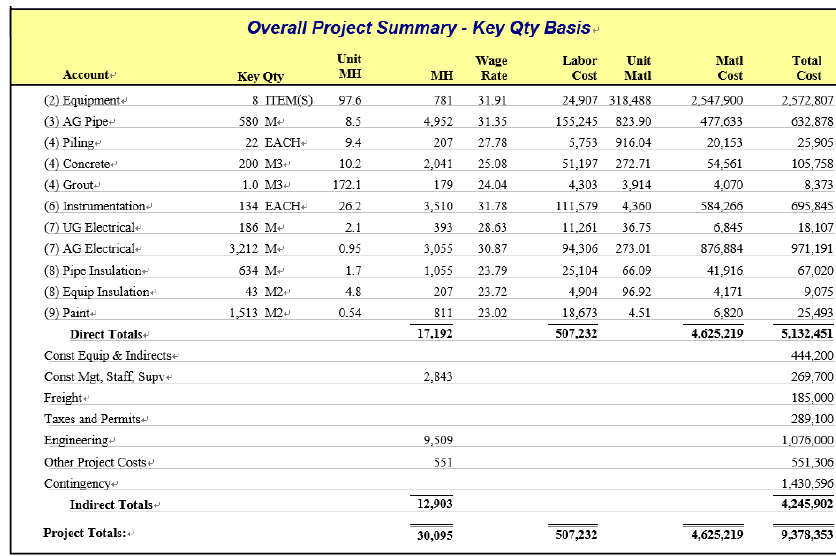
Figure 11. The estimated cost of the cyclo-pentane-RC system.